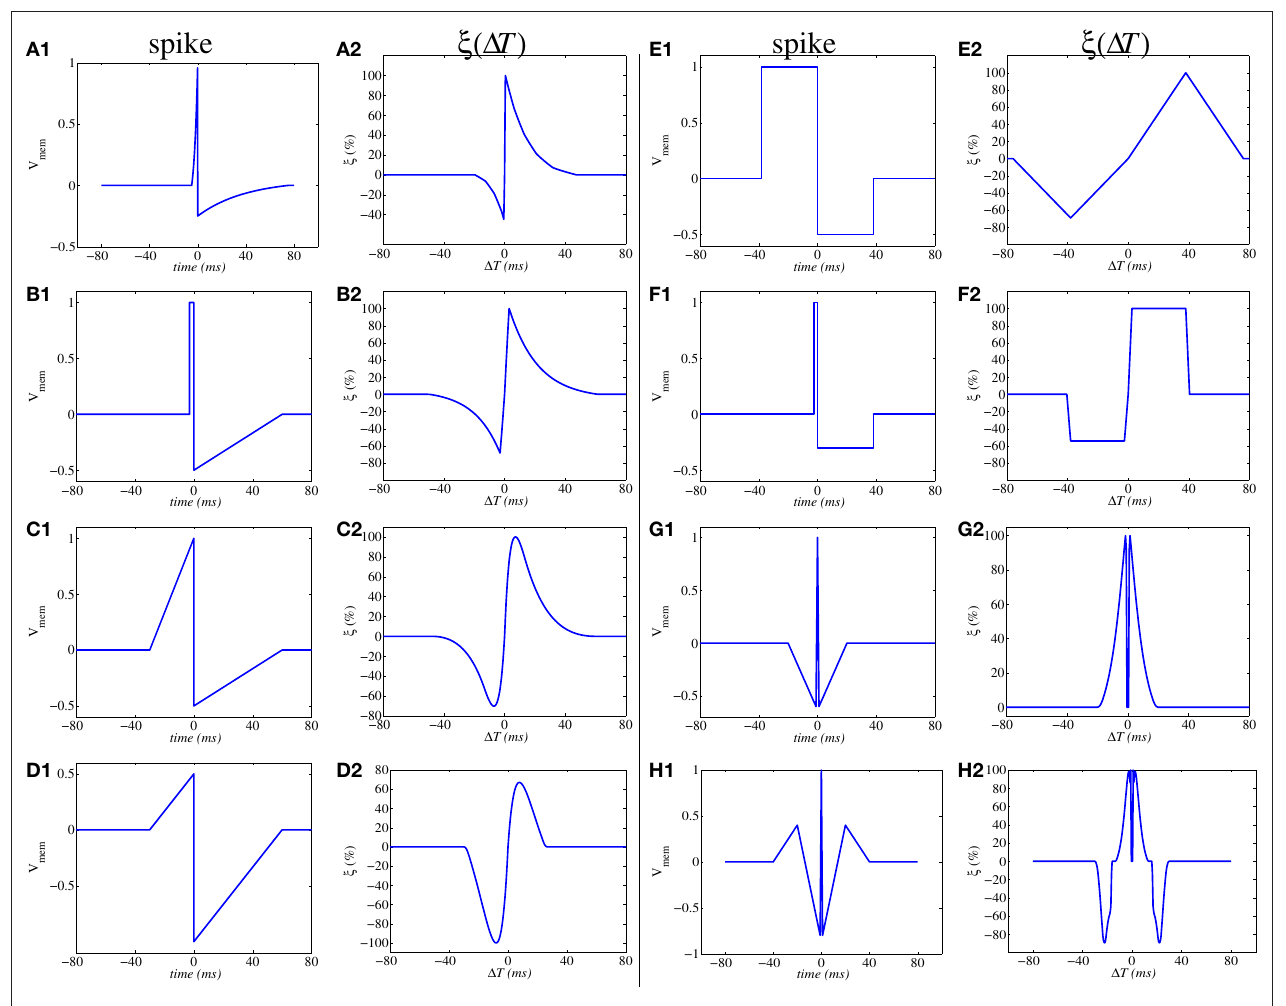
Figure 9 | illustration of influence of action potential shape on the resulting STDP resistance update function ξ ( ∆ T ). X1 is spike waveform and X2 is resulting STDP learning function, where X goes from (A–H)